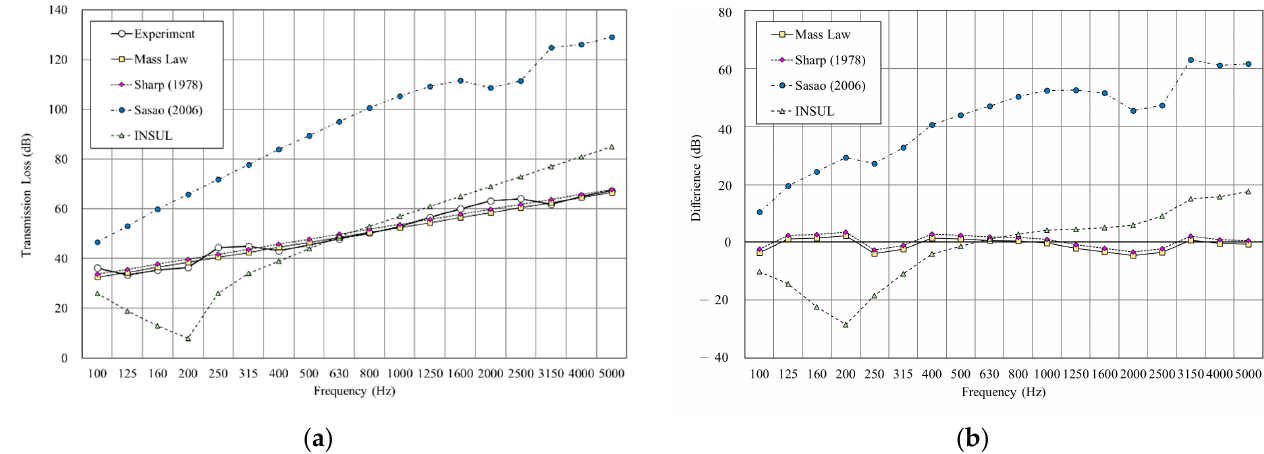
Figure 14. Comparison between experimental and predicted results of the double wall CLT with 75 mm cavity (B6). ( a ) The sound insulation performance of experiment and prediction. ( b ) The RMSE results of different prediction models.